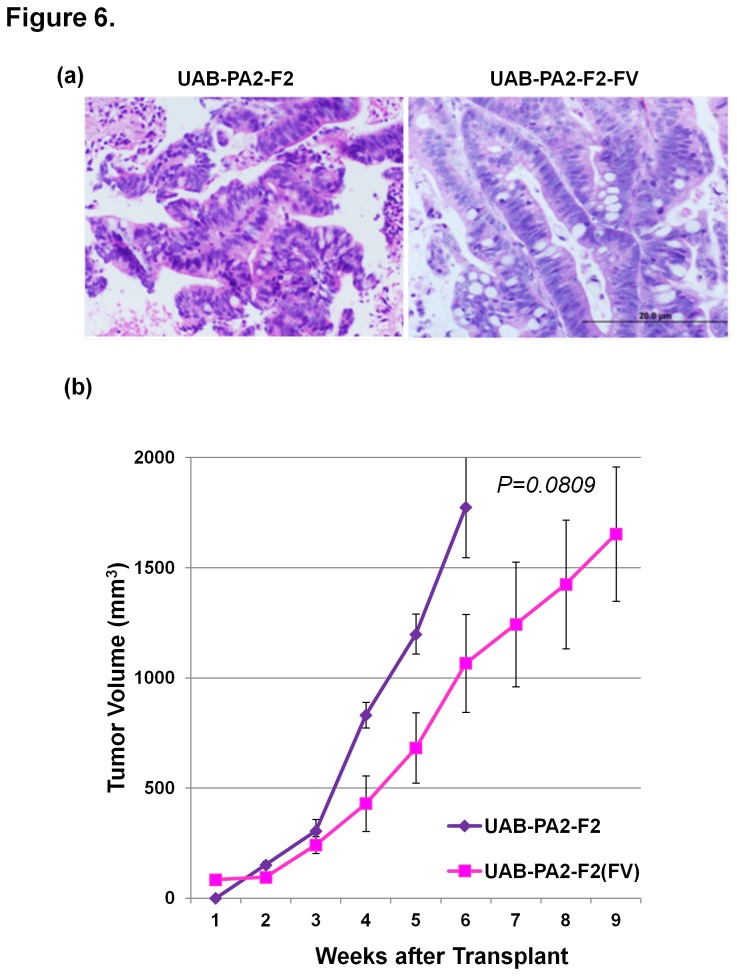
Cryopreservation of tumorgrafts does not alter the histology or growth kinetics in mice.(a) Photomicrographs of H&E stained sections of tumorgrafts produced from implantation of a primary tumor specimen within one hour of resection (UAB-PA2-F2)  compared to implantation of a specimen from the same tumor cryopreserved in liquid nitrogen for >30 days (UAB-PA2-F2-FV) show no histological differences. (b) Cryopreserved and fresh F0 tumor specimens produced tumorgrafts with similar growth kinetics in mice.  The apparent lag time of ~2 weeks prior to exponential growth of UAB-PA2-F2-FV tumorgrafts was not statistically significant (P = 0.0809).